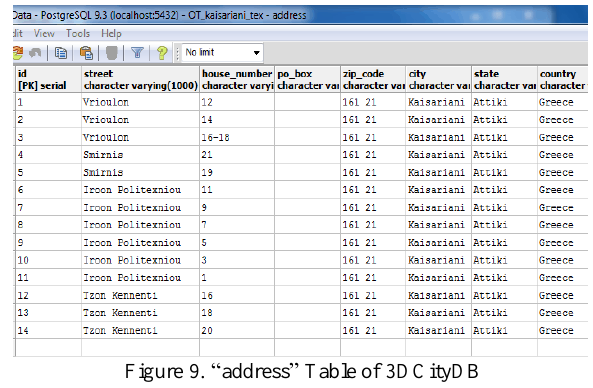
Figure 9. “address” Table of 3DCityDB